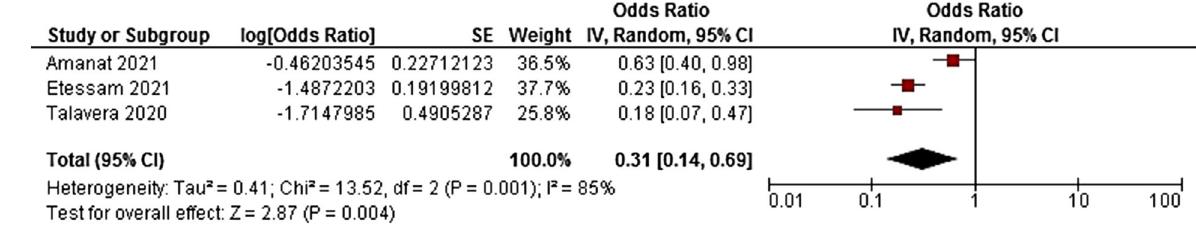
Fig. 2 Forest plot for the association of OD with death in COVID-19